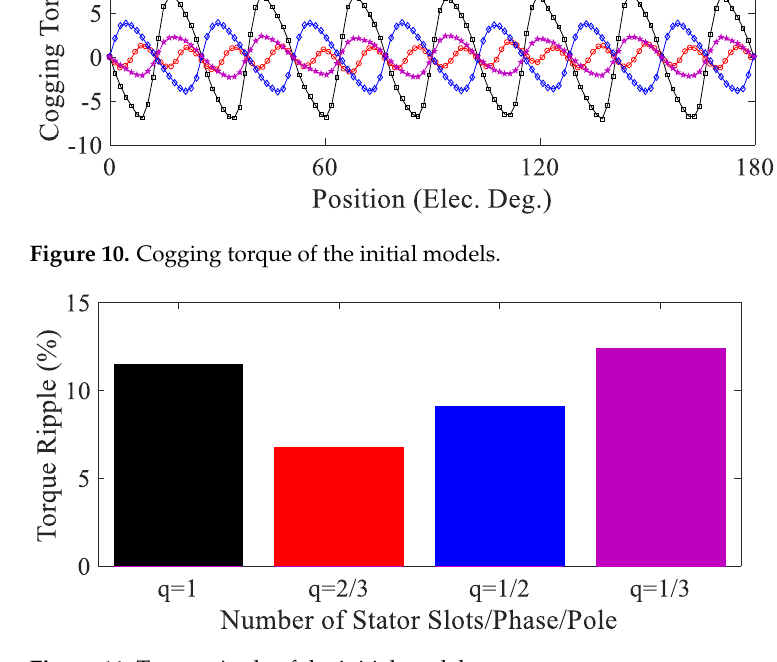
Figure 11. Torque ripple of the initial models.